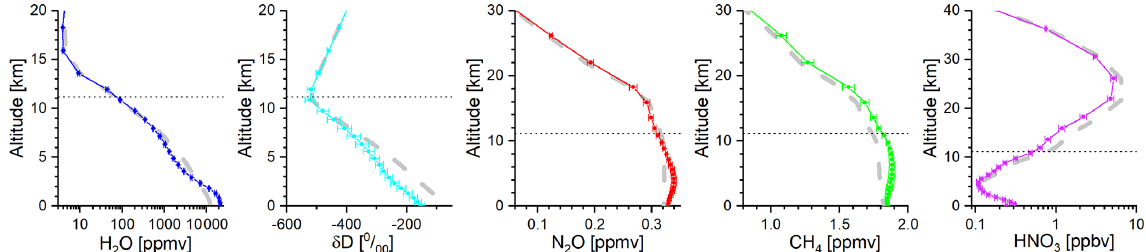
Figure 7. Example of vertical profiles of the targeted atmospheric trace gas products (H 2 O, δ D, N 2 O, CH 4 , and HNO 3 ): thick grey dashed lines represent the a priori assumption, and the coloured line with symbols and error bars are the retrieved values and the root-square sum of the fit noise error and the estimated temperature error. The data are for the 30 August 2008 example observation over Lindenberg (53 ◦ N) used for Fig.